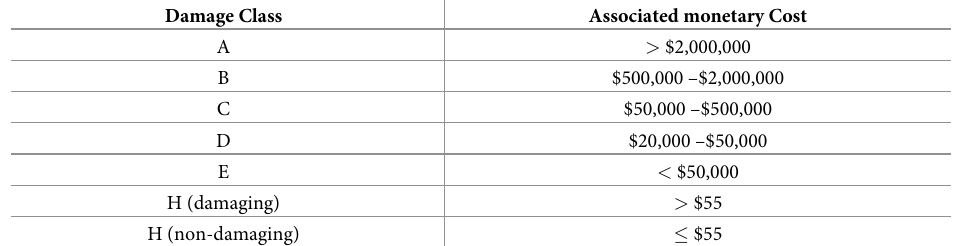
Table 1. Definitions of United States Navy (USN) and United States Air Force (USAF) damage classes in U.S. dol- lars. Damage class ‘H’ was divided for the USN dataset based on internal